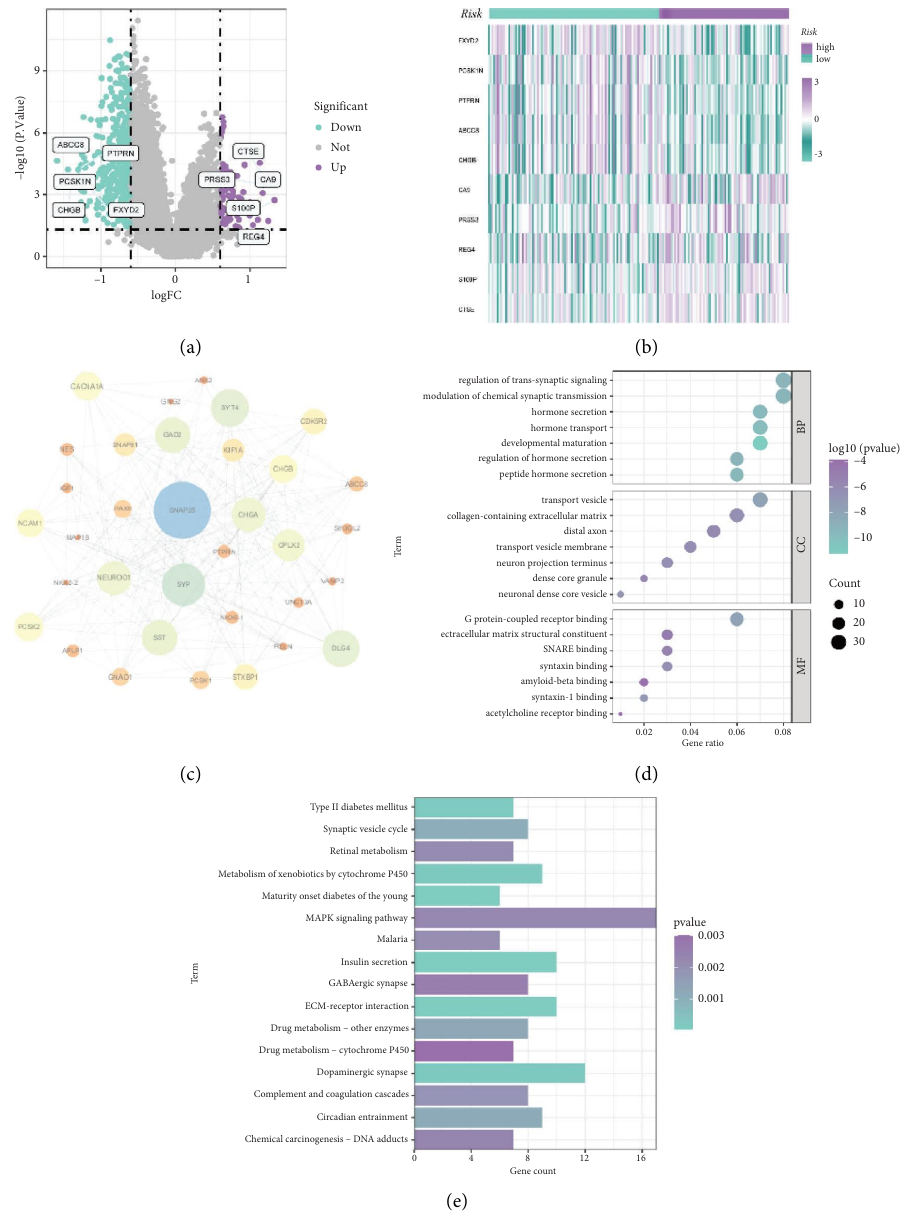
Figure 8: Functional enrichment analysis using GO and KEGG analysis. (a) Volcano diagram: each point represents a protein: down- regulated (purple), upregulated (green), and no signifcant (gray). (b) Heatmap: higher expression genes are shown in purple; lower expressions genes are shown in green. (c) PPI network of the most signifcant diference genes between two high- and low-risk groups. (d) GO analysis. (e) KEGG